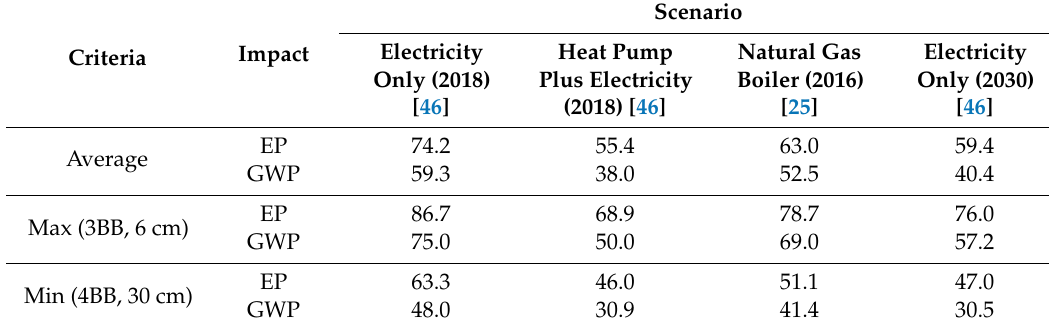
Table 11. Criteria for comparing the impacts for di ff erent energy supply